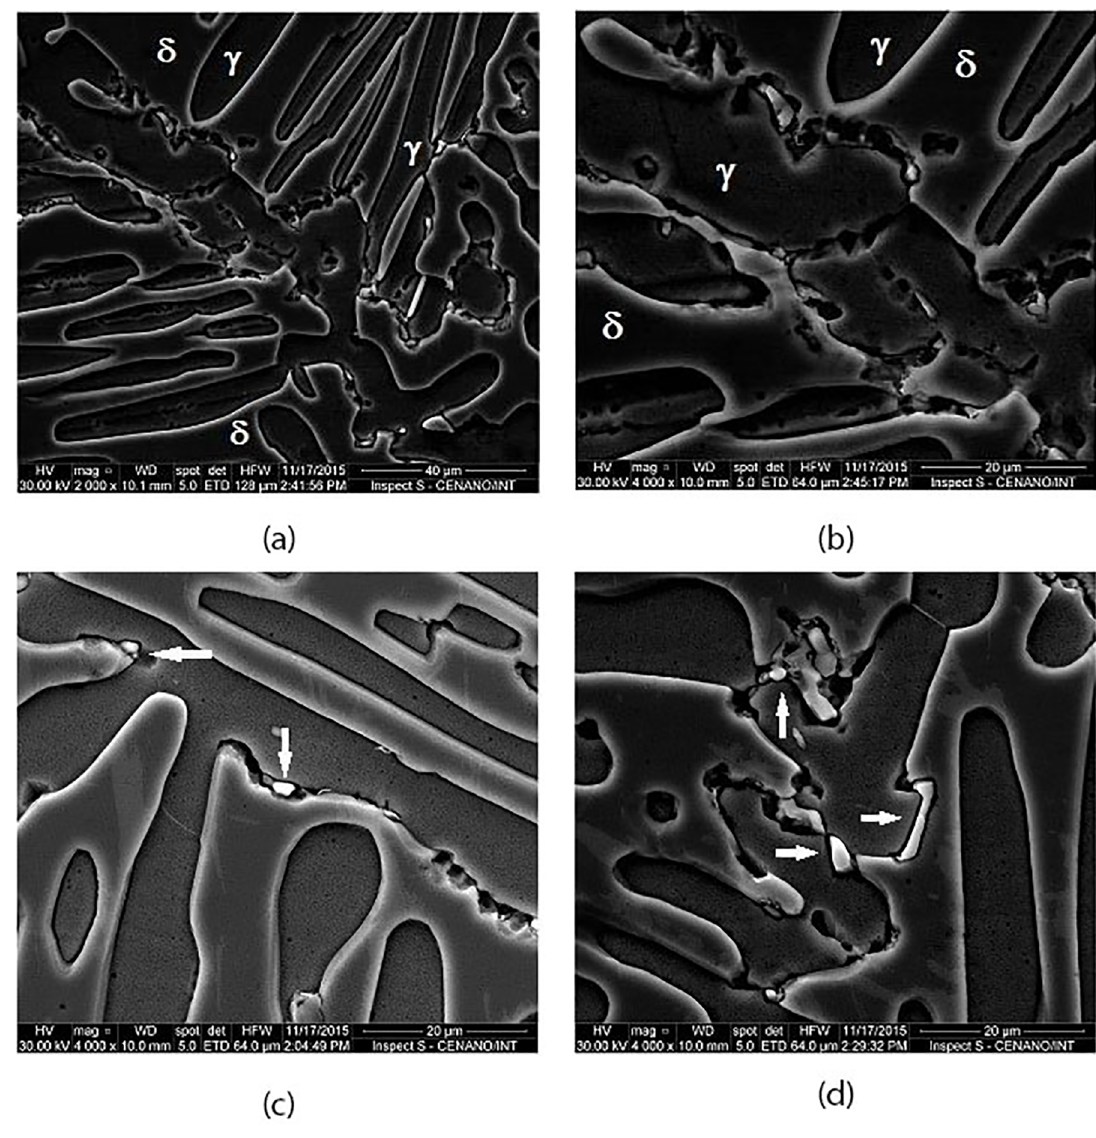
Figure 5. SEM images, after DL-EPR test in the specimen aged at 475 ºC for 12